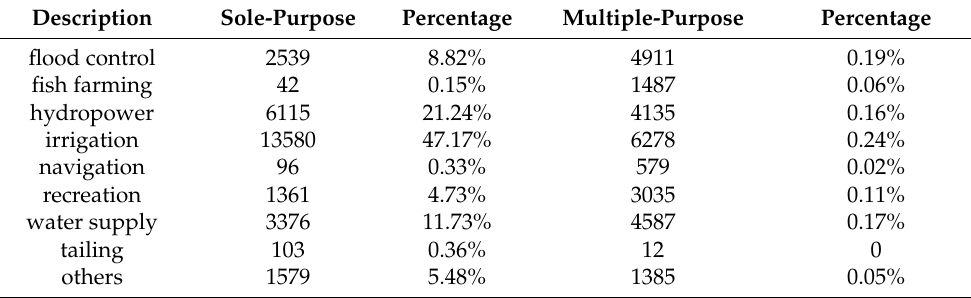
Table 6. Purposes of dams.